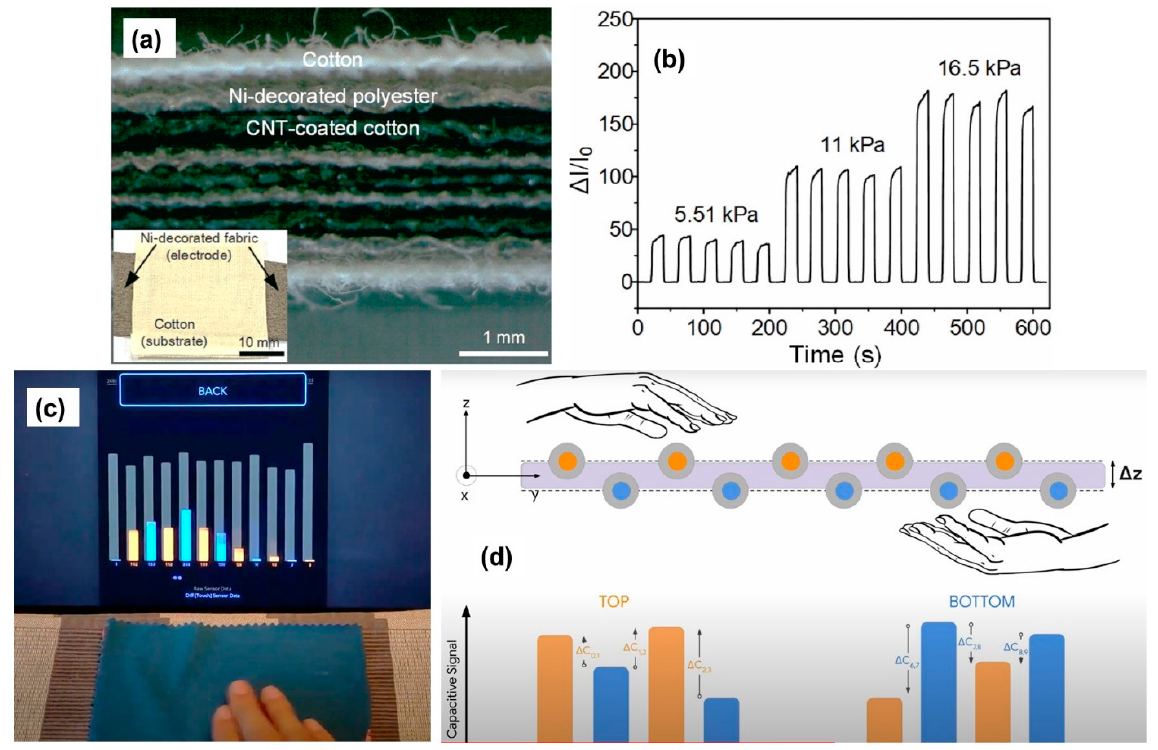
Figure 17. ( a ) Optical microscope image showing cross-sectional view of the sensor. The image clearly shows MCNT-coated cotton/Ni-decorated polyester layers and cotton substrates. Inset is a photograph of as-fabricated sensor. ( b ) Transient responses of the sensor under repetitive loading/unloading cycles for various pressures (5.51, 11 and 16.5 kPa). ( c ) A video snapshot of the operator touching the fabric with four fingers. ( d ) Schematic representation of bottom and top touch action by hand and the relevant capacitive response. The sensor operates stably and exhibits immediate response to the loaded/ unloaded pressure. Reprinted/adapted with permission from Ref. [174]. Copyright 2020, Association for Computing Machinery (ACM).